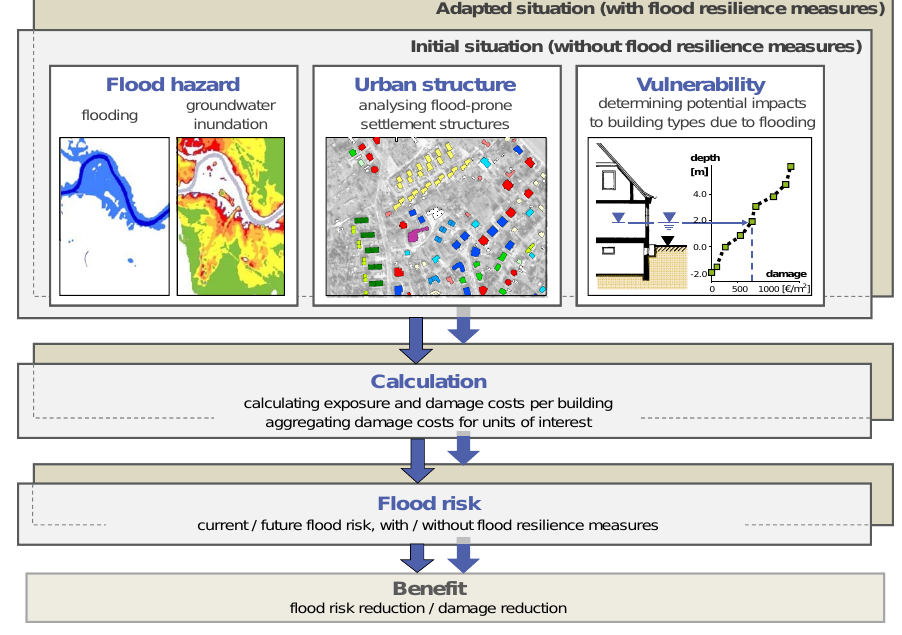
Figure 1. Model approach HOWAD/GRUWAD considering the effects of flood-resilience measures ([32,33], modified).